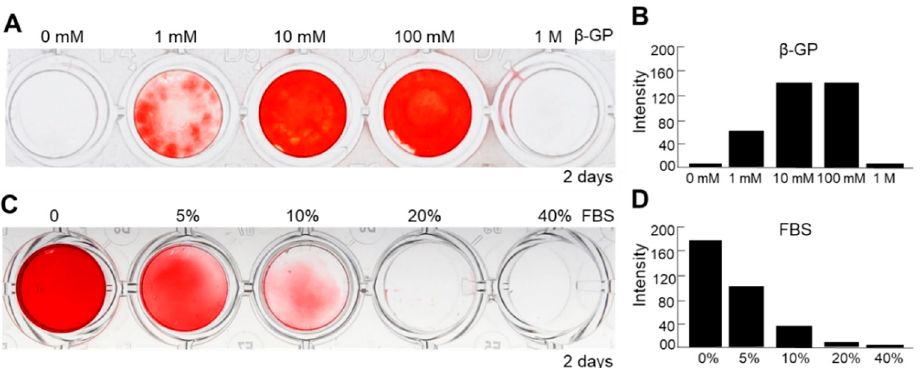
Figure 8. Analysis of factors affecting the mineralization of ATDC5-derived cell nanofragments (300 µ g / mL). ( A , C ) ARS staining of cell nanofragments incubated for 2 days with increasing doses of β -glycerophosphate ( β -GP, ( A )) or fetal bovine serum (FBS, ( C )). ( B , D ) Graphs show the quantitative analysis of ARS staining performed with ImageJ. Note that β -GP at concentrations of 10 mM or 100 mM of enhanced ( A , B ), while fetal bovine serum (FBS) inhibited in a dose-dependent manner ( C , D ), the mineralization of nanofragments. Beta-GP at a concentration of 1 mM partially promoted the mineralization of nanofragments. Alpha-MEM was used as the vehicle in the experiments. In the studies with di ff erent concentrations of FBS, 10 mM β -GP was added in all